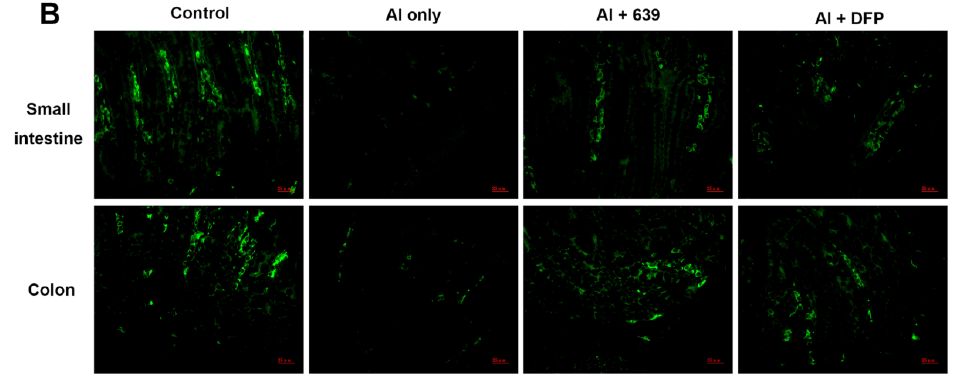
Figure 2. Effects of L. plantarum CCFM639 on Al ‐ induced alterations of tight junction protein claudin ‐ 1: in vitro ( A ); and in vivo ( B ). The claudin ‐ 1 levels in HT ‐ 29 cell (therapy assay) and intestine of mice (intervention assay) were observed with confocal microscopy and stained by Alexa Fluor 488 (green).